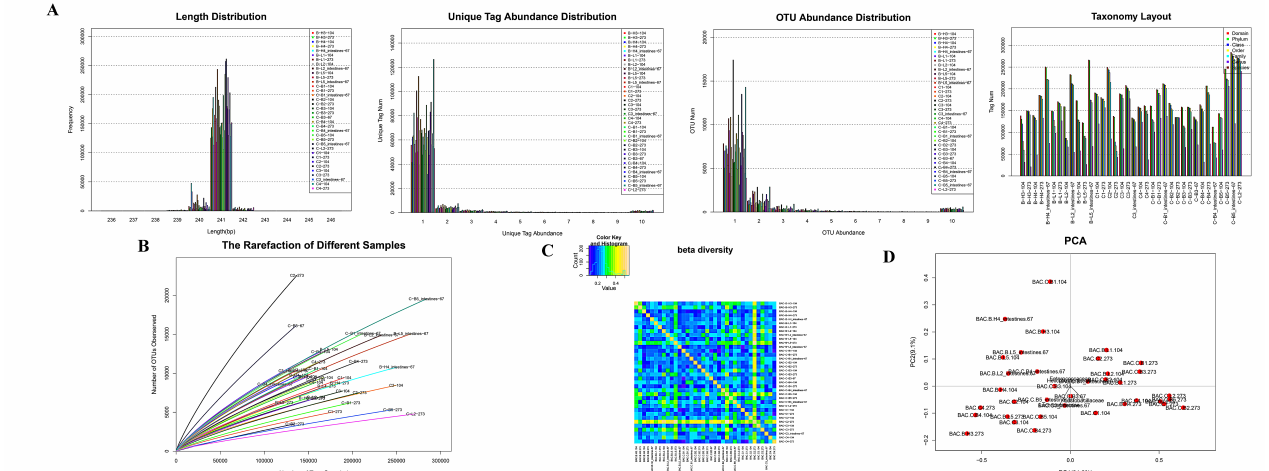
Figure 3. The tags abundance statistics: ( A ): The length distribution of tags in each group; The tags abundance distribution in each group; The OUT distribution in each group; The number of tags in each classification level of each sample was statistically analyzed. ( B ): The dilution curve of each group. ( C ): The beta diversity of samples in each group. ( D ): The PCA diagram of samples in each group.